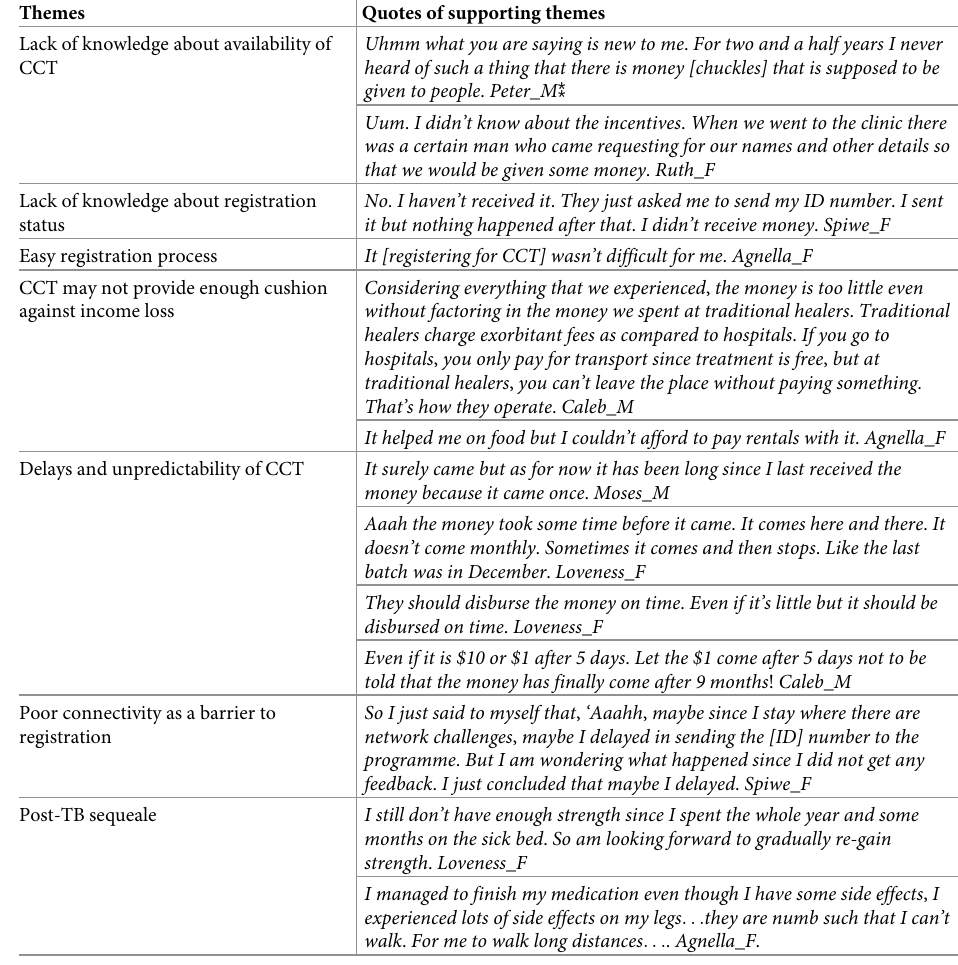
Table 3. Additional themes and